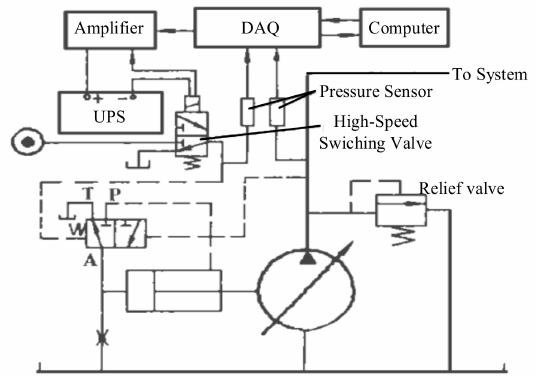
Figure 11. Digital hydraulic pump controlled by high-speed switching